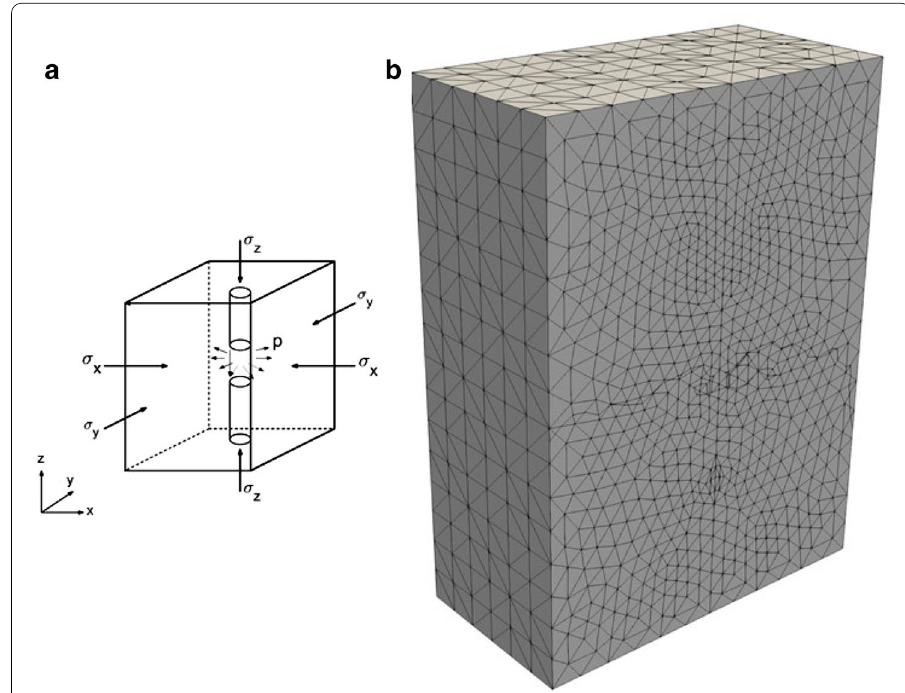
Fig. 2 Laboratory test. a Geometry and initial confinement of the concrete block. b Section of the discretized concrete block, showing the node refinement in proximity of the center of the specimen. The mesh comprises 6280 solid 10-noded tetrahedra and 8945 nodes